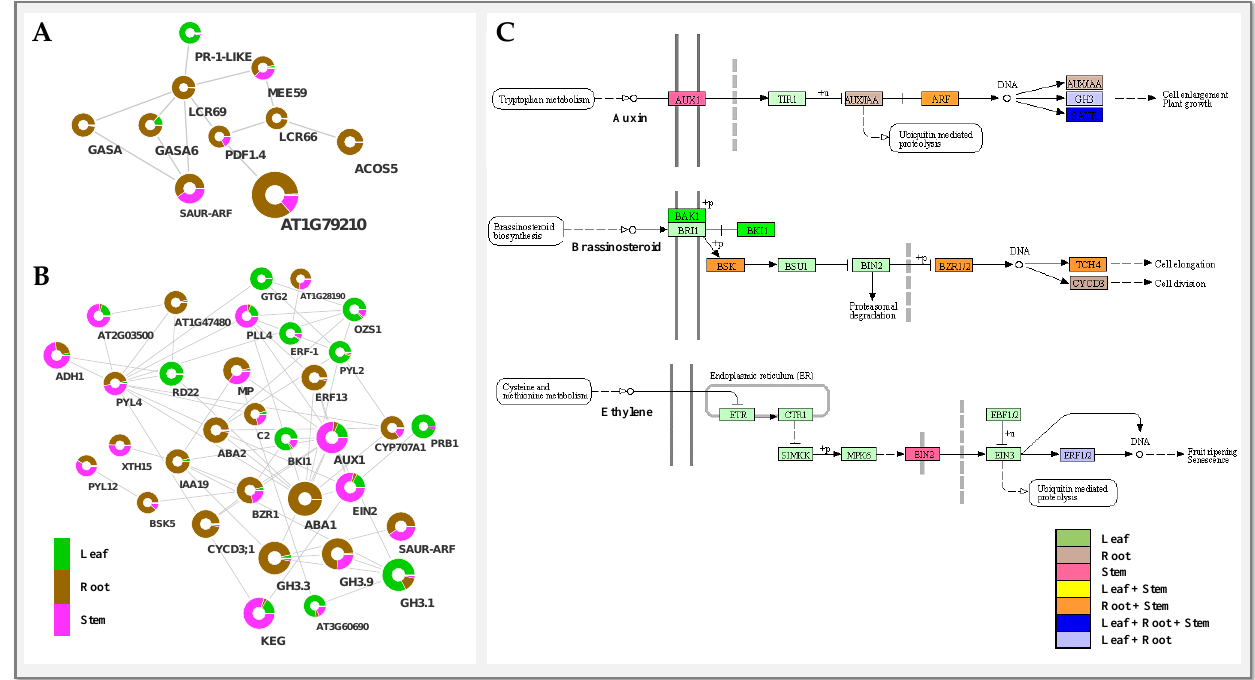
Figure 8. Predicted network representing ( A ) antiviral pathogenesis-related and ( B ) phytohormones. ( C ) KEGG based spatial enrichment of auxin, brassinosteroid and ethylene related pathways involved in antimicrobial activities in I. racemosa